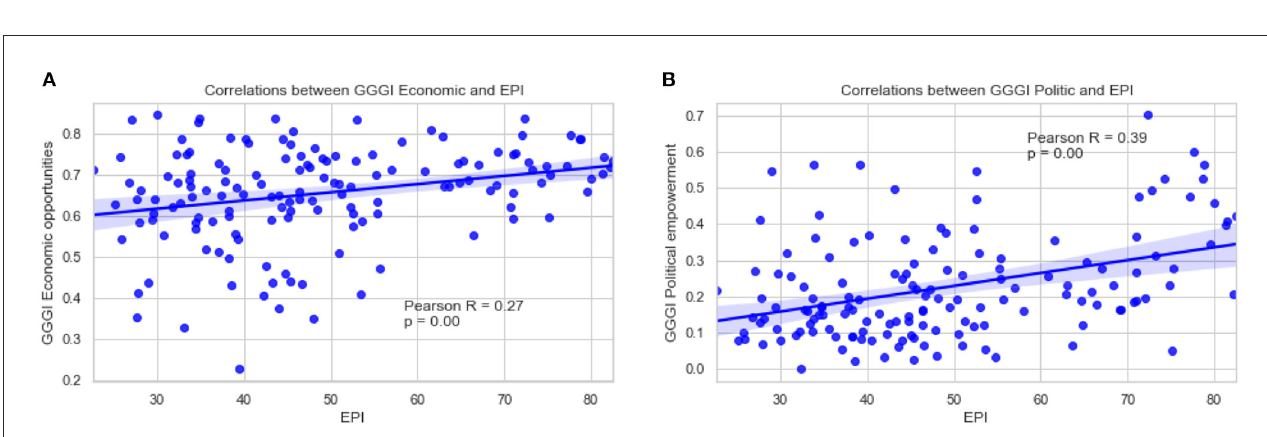
FIGURE4 (A) Correlation between EPI and the economic opportunities sub-component of the GGGI. (B) Correlation between EPI and the political empowerment sub-component of the